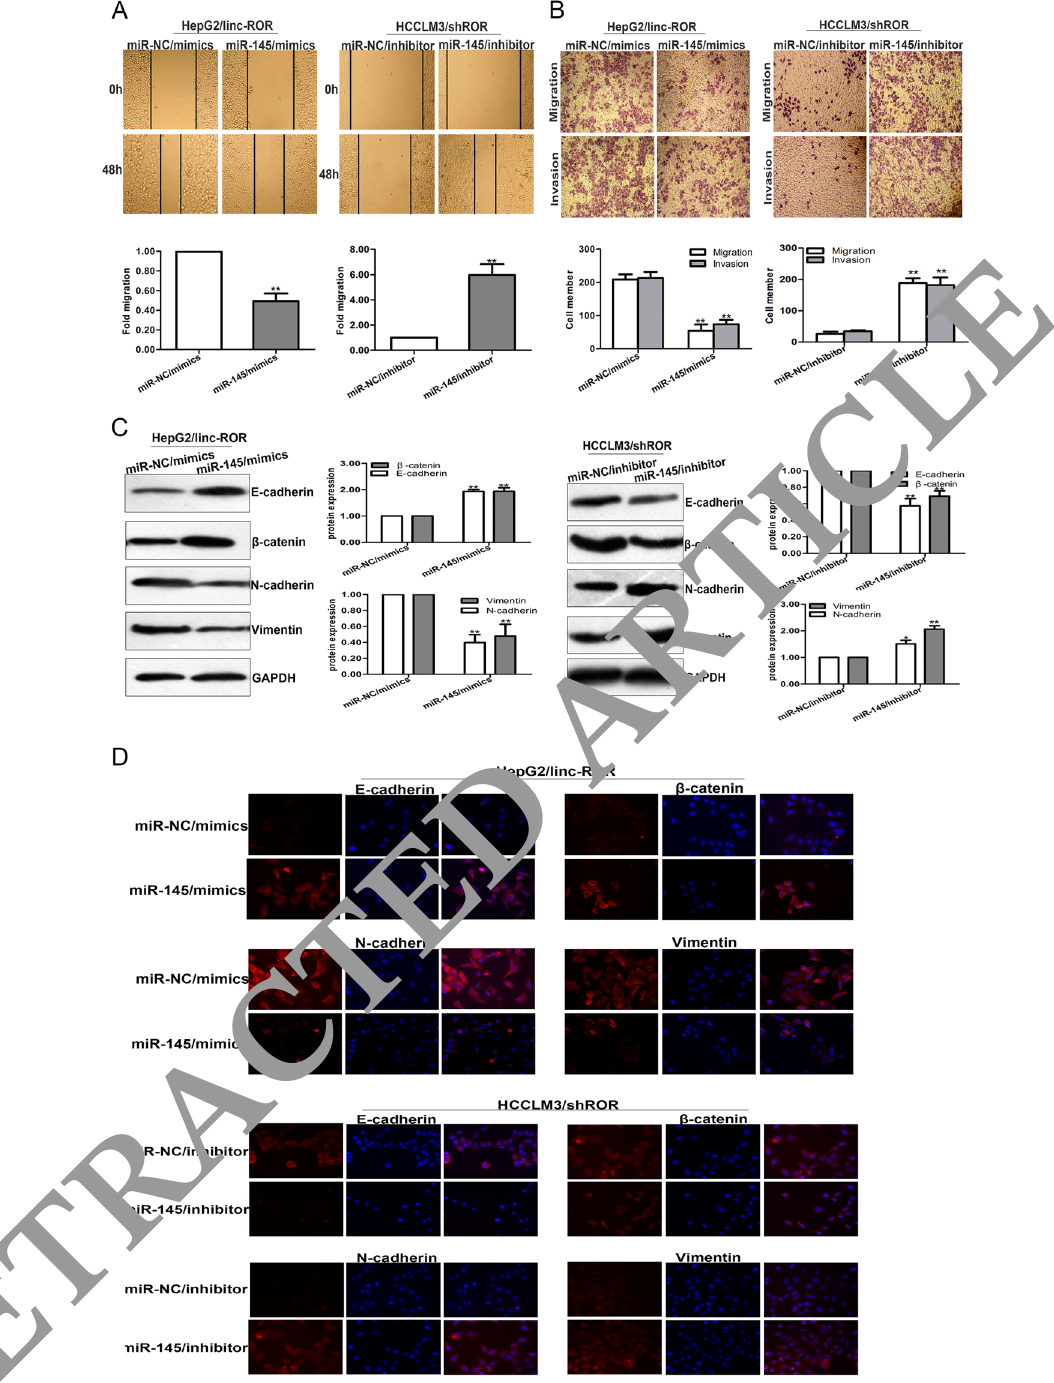
Figure 6. The function of linc-ROR in invasion and migration of HCC cells in vitro was dependent on miR-145. ( A ) Wound healing assay was performed to determine the mobility capacity of HepG2 cells stably transfected with linc-ROR and HCCLM3 cells stably transfected with shROR in the presence of miR-145/mimics or miR- 145/inhibitor, respectively. ( B ) The metastasis capacity of HepG2 cells stably transfected with linc-ROR and HCCLM3 cells stably transfected with shROR was partially rescued by miR-145/mimics and miR-145/inhibitor, respectively. ( C ) Western blotting and ( D ) immunofluorescence analysis of changes in epithelial markers and mesenchymal markers in HepG2 cells stably transfected with linc-ROR and HCCLM3 cells stably transfected with shROR after treatment with miR-145/mimics or miR-145/inhibitor, respectively. Each experiment was performed at least three times. * p < 0.05; ** p <